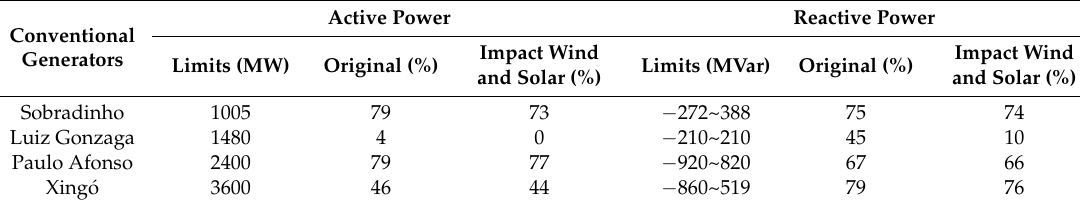
Table 4. Available Powers: Conventional